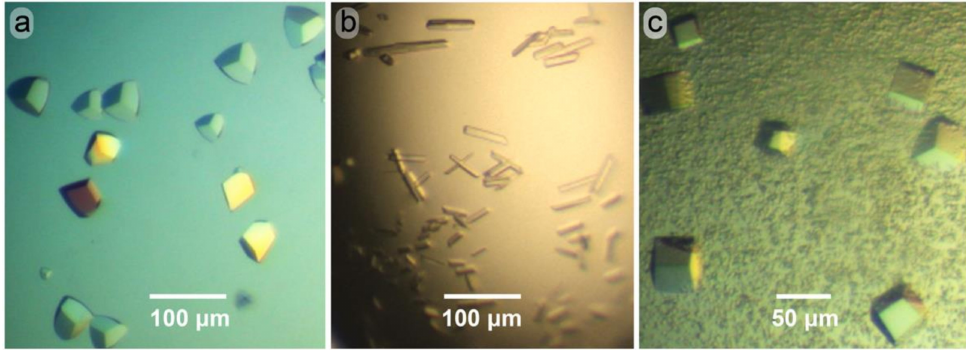
Figure 5. Representative crystals of dmU1A(F37M/F77M) labeled with selenomethionine. ( a ) Trigonal crystals grown in the absence of RNA from solutions of Na-acetate buffered at neutral pH. Here and elsewhere, crystals were photographed under polarized light. ( b ) Rods of dmU1A(F37M/F77M) bound to the hpII 21-mer RNA. Crystals grew from solutions of polyethy- lene glycol buffered at neutral pH. ( c ) Cubic crystals of dmU1A(F37M/F77M) in complex with a preQ 1 -II riboswitch 84-mer. Crystals grew from lithium sulfate buffered at pH